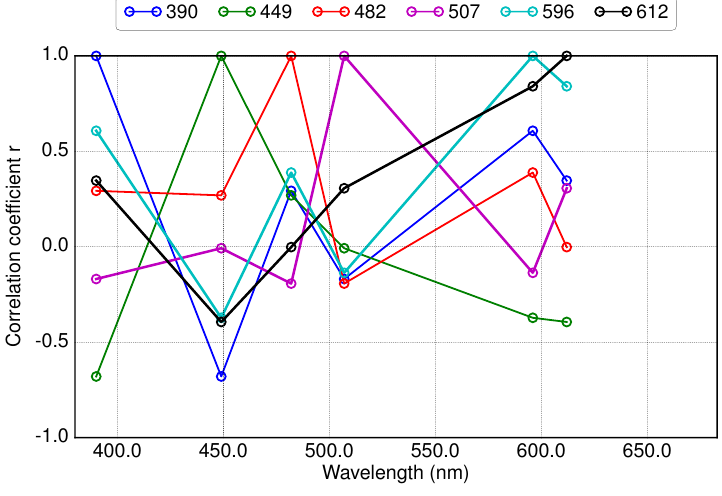
Figure 6. Correlation coefficients of normalized absorption coefficients of simulated mixtures ( ¯ a ∗ φ ( λ ) ) at wavelengths chosen for coccolithophores (highest correlation of second derivatives of ¯ a ∗ φ ( λ ) at these wavelengths and chl-a concentration of coccolithophores); ¯ a ∗ φ ( λ ) at each band indicated in the legend was used as the independent variable, respectively, while ¯ a ∗ φ ( λ ) at other bands was considered as the dependent variable. A correlation coefficient for linear regression was then calculated for each ¯ a ( λ ) ∗ φ